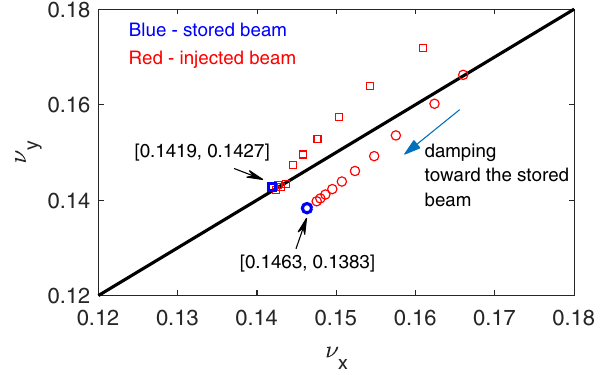
FIG. 6. Changing betatron tunes for the injected beam for the full coupling correction case when the stored beam tunes are [0.1419, 0.1427] (squares) or [0.1463, 0.1383] (circles).